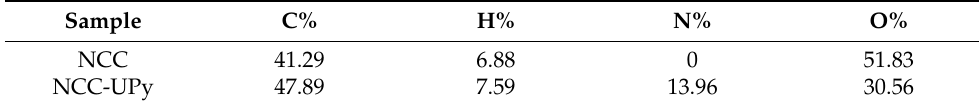
Figure 7. Absorbance curves of NCC-UPy at 282 nm as a function of concentration. Table 1. Elemental analysis results for NCC and NCC-UPy.